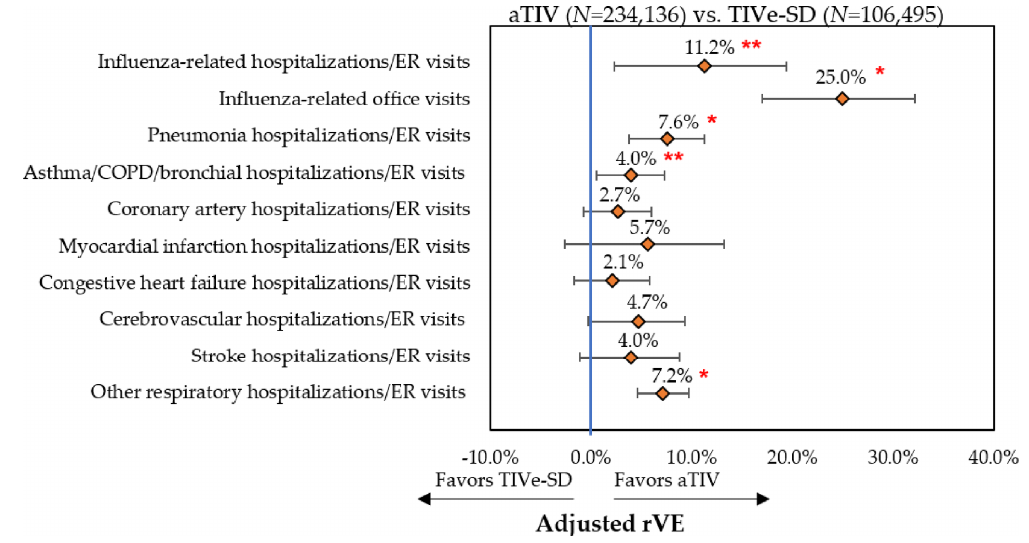
Figure 7. Adjusted rVE — post-IPTW and Poisson regression — aTIV vs. TIVe-SD. * p < 0.001; ** p < 0.05; rVE = relative vaccine effectiveness.